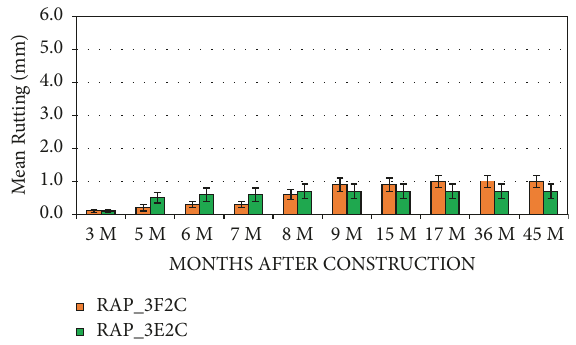
Figure 9: Mean rutting (and standard error) vs. months after construction (RAP_3F2C and RAP_3E2C).